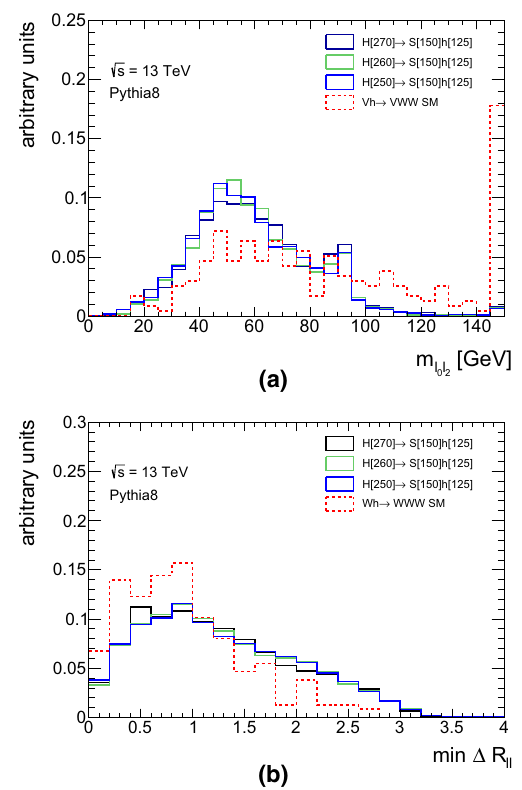
Fig. 1 Invariant mass of the lepton with different electric charge and theleptonoriginatingfromthe W bosonradiatingtheSMHiggsparticle ( a ) and minimal distance between leptons ( b ) in the Wh 3 (cid:4) channel for several H → Sh samples (solid lines) compared with the SM Vh process with h → WW (dashed line) generated with PYTHIA8 . The last bin contains overflow